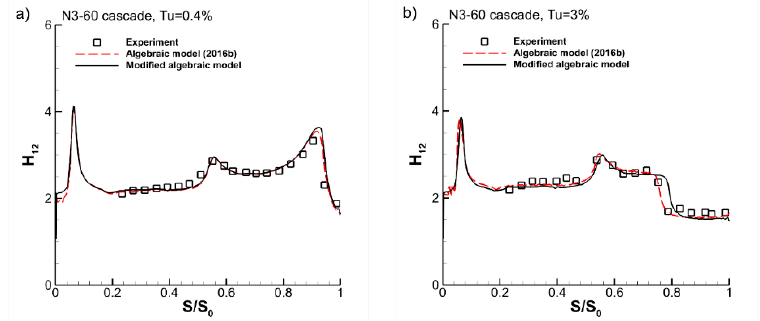
Figure 11. N3-60 turbine cascade. Shape factor on the suction side with ( a ) low ( Tu = 0.4%) and ( b ) high ( Tu = 3%) turbulence